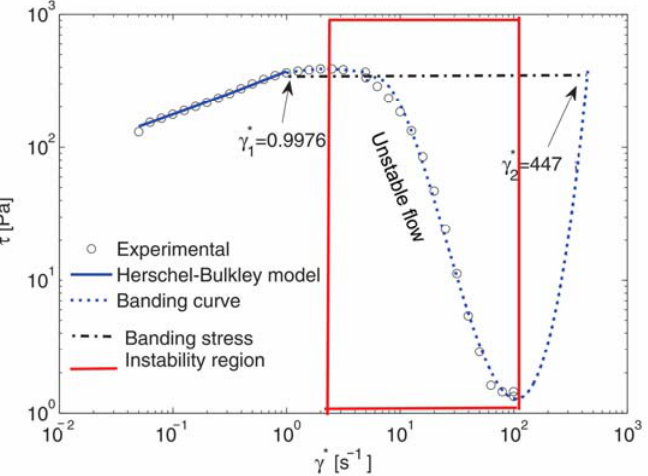
Figure 5. Schematic flow curve, showing the two stable branches with γ(cid:4662)(cid:3407)γ(cid:4662) 1 and γ(cid:4662)(cid:3408)γ(cid:4662) 2 . In the un ‐ stable region γ(cid:4662) 2 (cid:3408)γ (cid:4662) (cid:3408)γ(cid:4662) 1 the stress is assumed constant 𝜏 (cid:3404) 𝜏 (cid:3029)(cid:3028)(cid:3041)(cid:3031) .